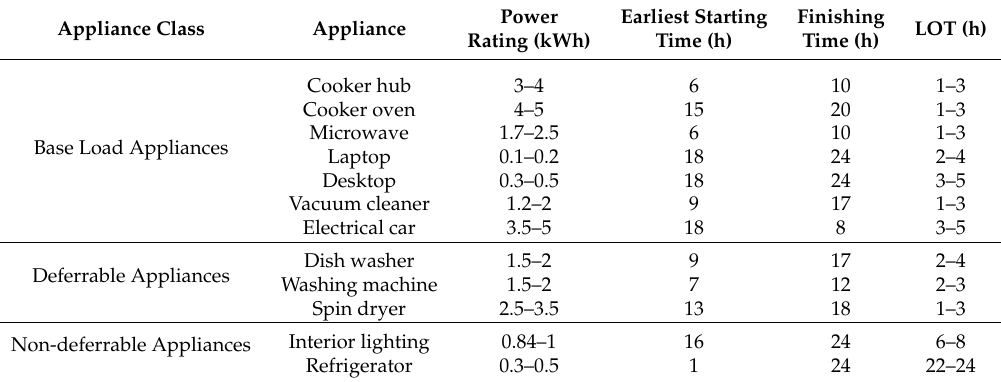
Figure 1. Status of appliances’ execution pattern. Table 2. Parameters of appliances. LOT, Length of Operational